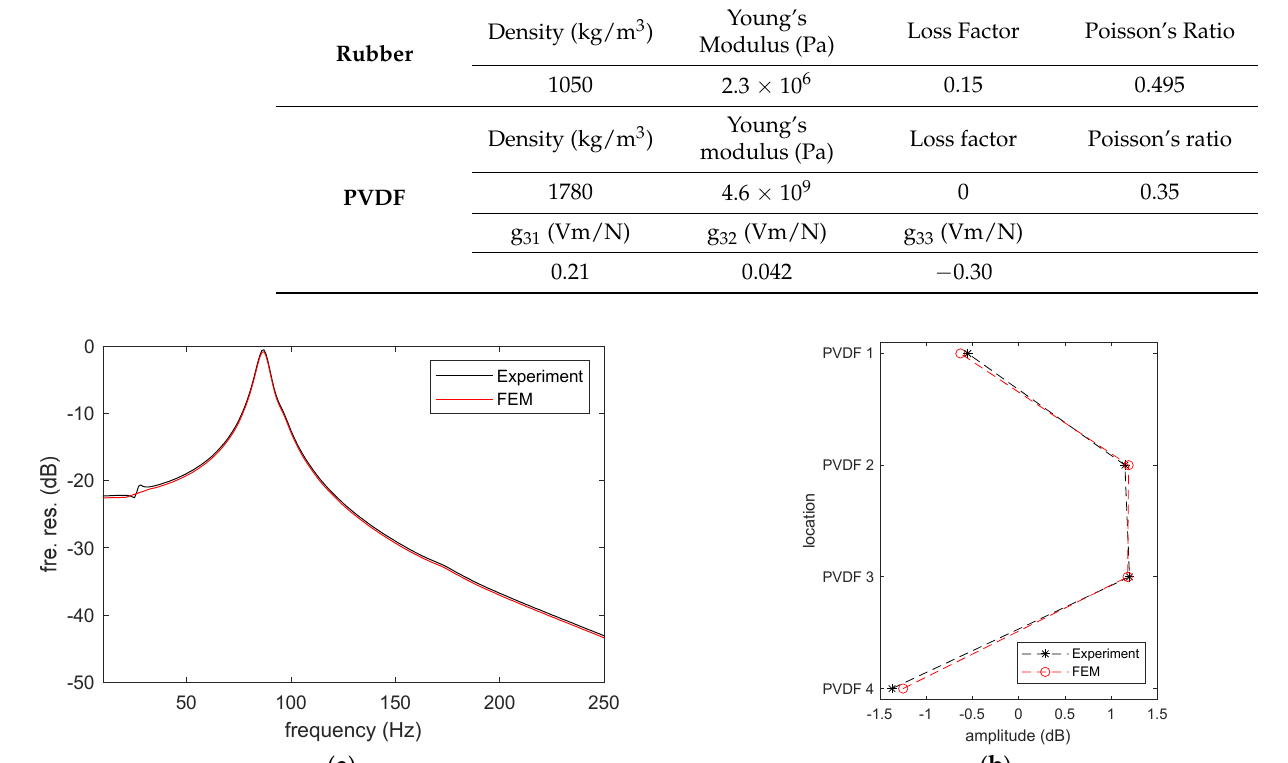
Figure 4. Comparison between the FE model and experiment: ( a ) frequency response of PVDF 1 and ( b ) output distribution of the PVDF array at 87 Hz.